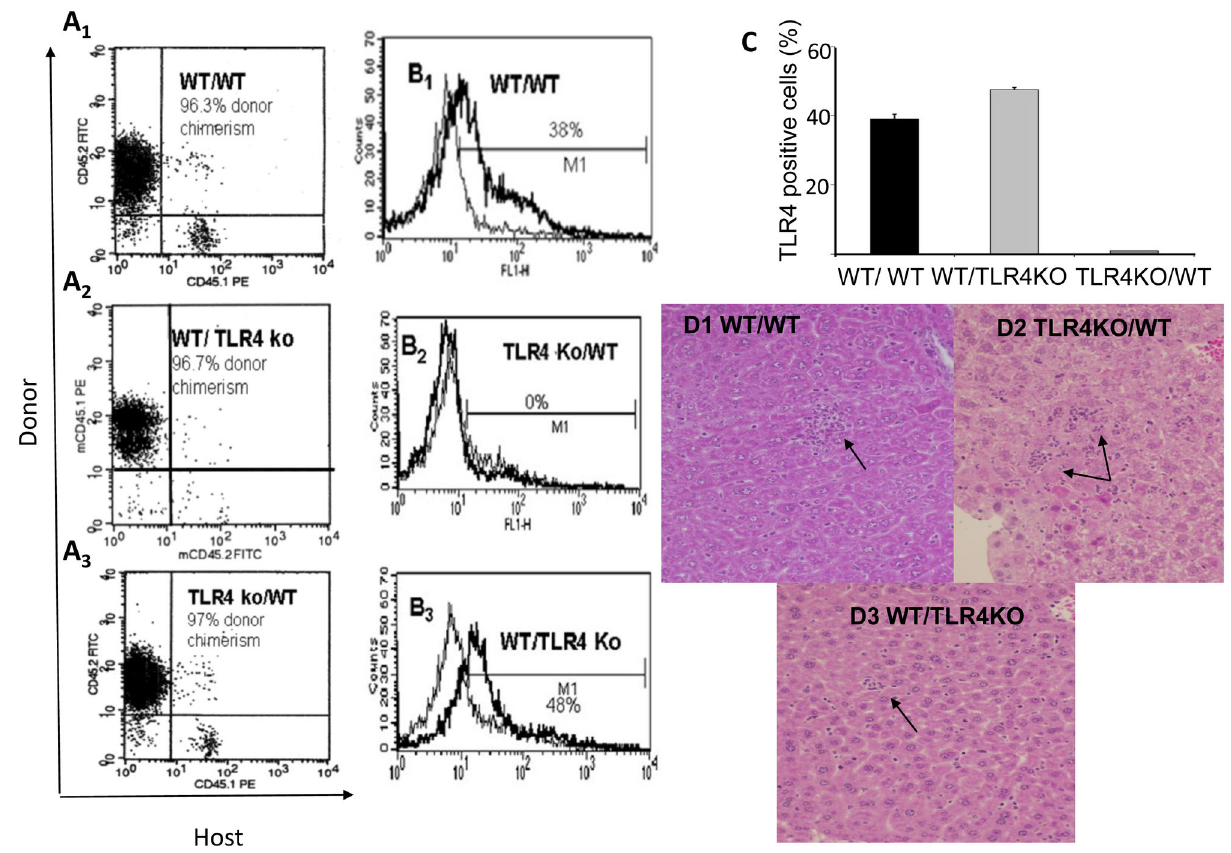
Figure 4. LPS challenge to hepatocytes and resident macrophages. To investigate the role played by hepatocytes